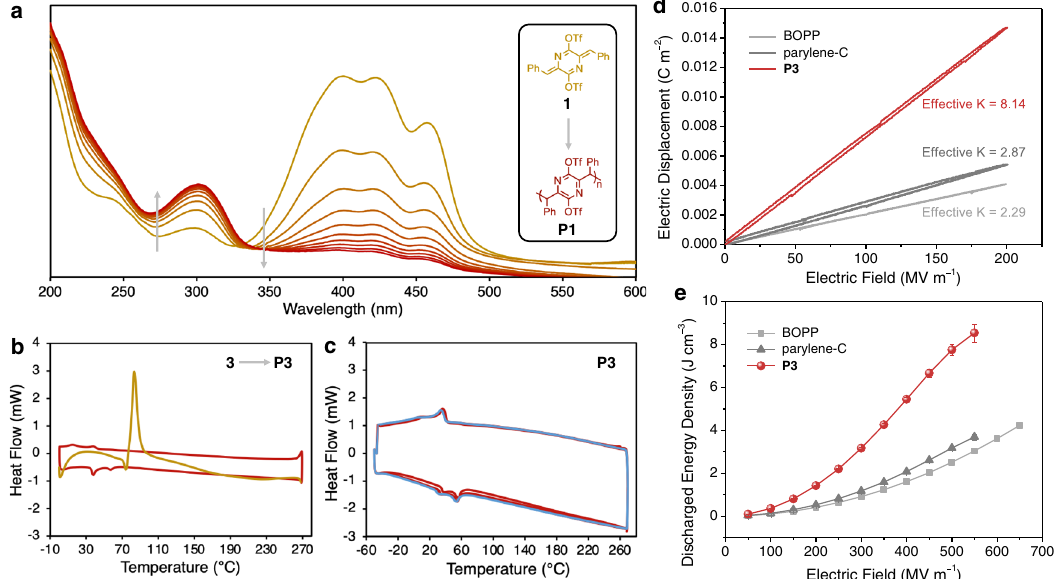
Fig. 3 Optical and thermal interrogation of the topochemical polymerization of AQMs and capacitive energy storage properties of polymer P3. a UV- Vis scanning kinetic curves of a fi lm of 1 (gold) as it polymerizes to form P1 (ruby) over the course of roughly eight hours. b and c DSC studies of monomer 3 and the in-situ thermally polymerized P3 . b the fi rst heating (gold), and the subsequent cycle (ruby) of 3 as it polymerizes to P3 . c multiple heating and cooling cycles (ruby = fi rst four cycles, blue = fi nal cycle) of P3 . d Comparative electric displacement-electric fi eld ( D - E ) loops at 200 MV m – 1 showing the effective K values derived therefrom. e discharged energy density plots as a function of the electric fi eld, showing the superior energy storage properties of P3 against parylene-C and BOPP (BOPP = biaxially oriented polypropylene; error bars represent standard deviations obtained from at least three measurements using different